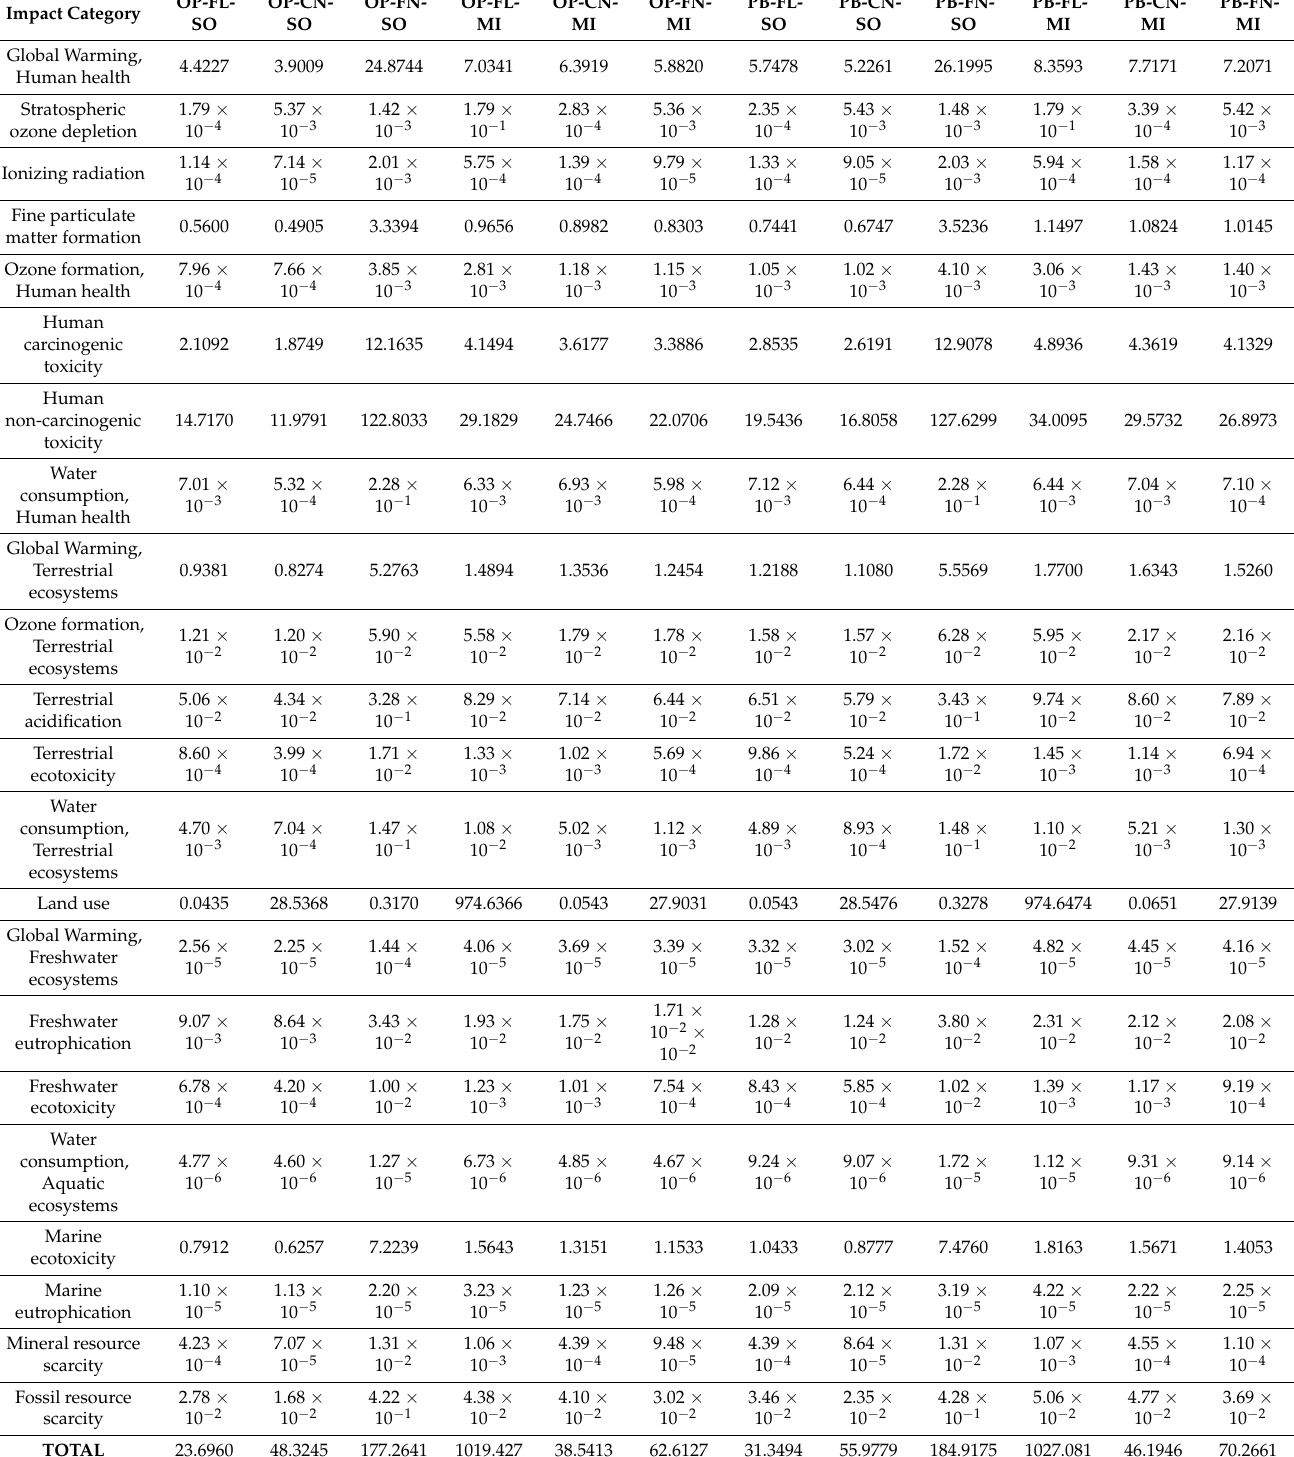
Table A7. Life cycle assessment results for 1 kg of